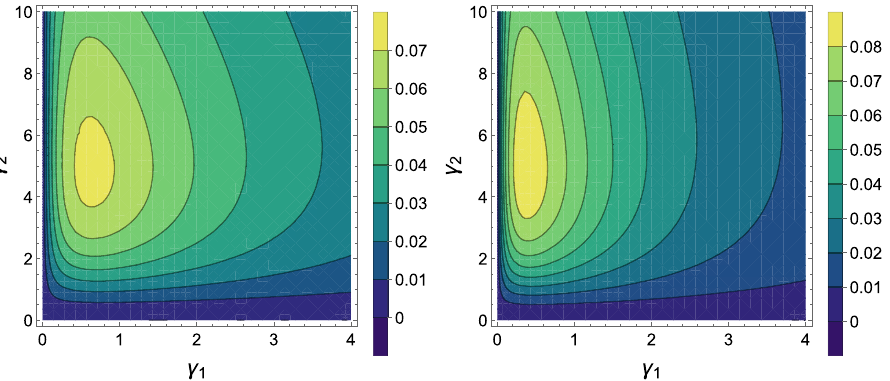
Figure 4. Contour plots of the discord of state ρ in Eq. ( 4) corresponding to ¯ n b = 0 and ¯ n a = 1 (left) and ¯ n = 2 (right) as a function of γ 1 and γ 2 , with J = 1 and D = 1 for both a